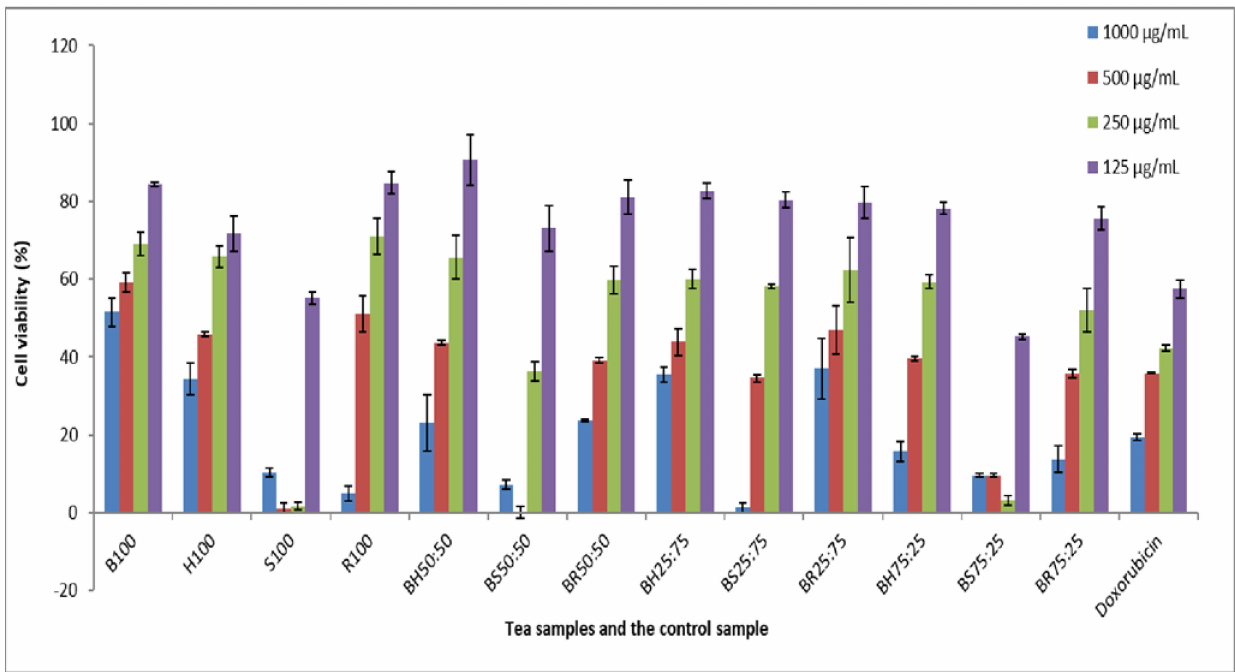
Figure 1. Results of cell viability of Vero cells (African green monkey kidney cell line) after treatment with selected tea samples. Y -axis shows percentage cell viability at different concentration. X -axis represents different tea samples together with the